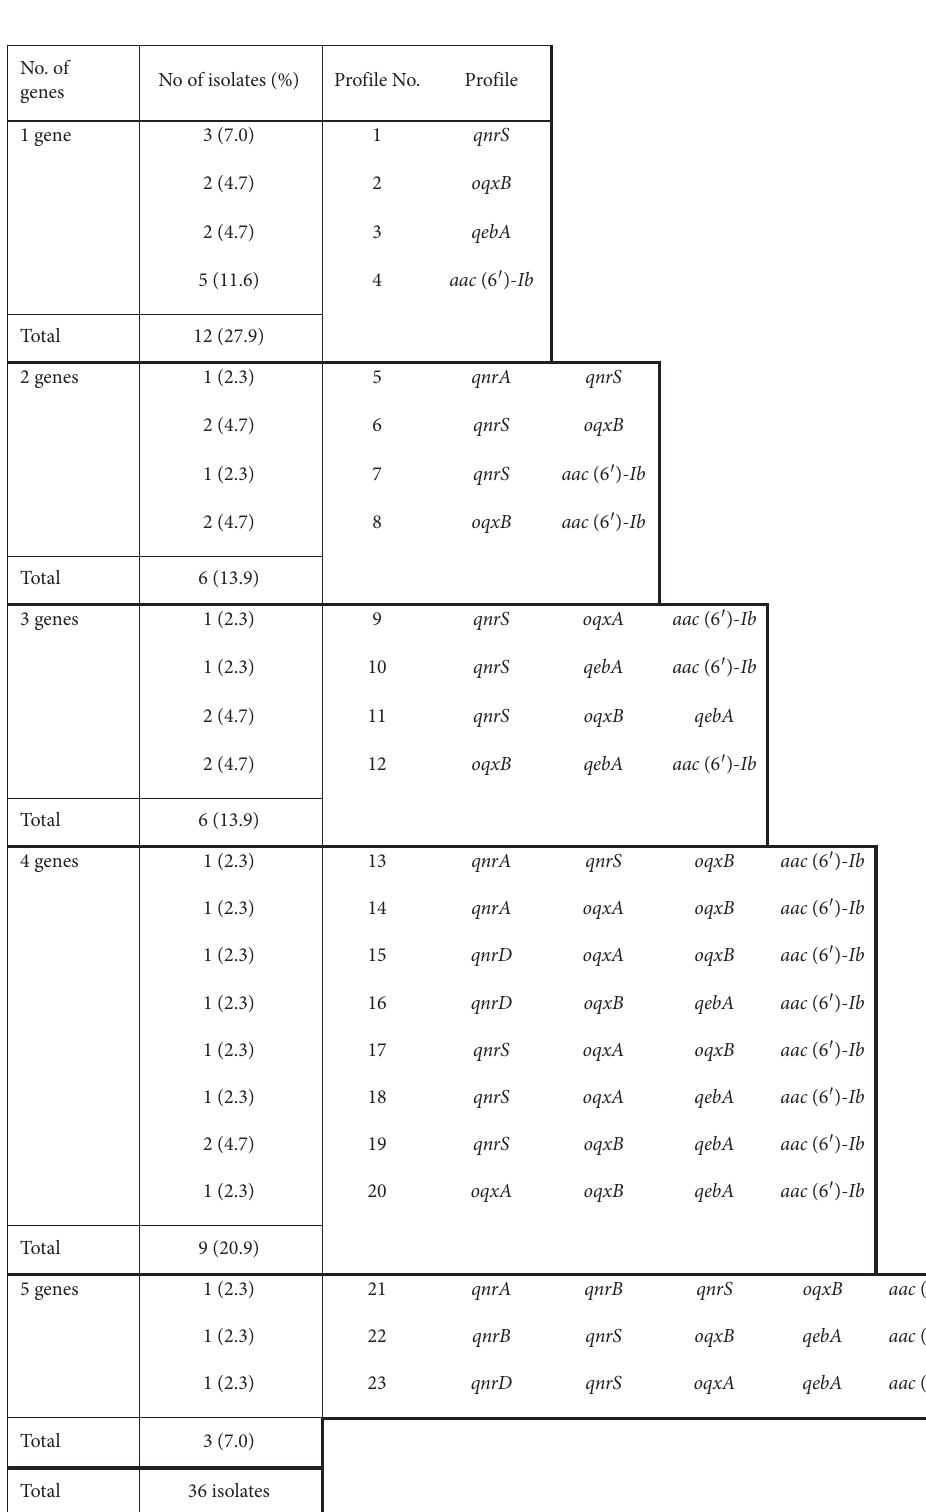
Figure 1: The gene profile of PMQR genes among the 36 clinical E. coli